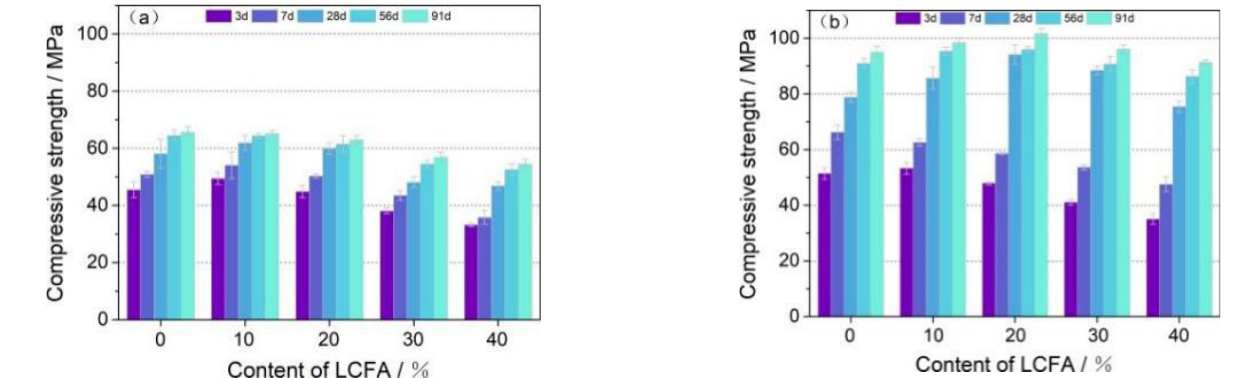
Figure 7. Compressive strength of OPC-LCFA samples. ( a ) Dry. ( b ) Water .